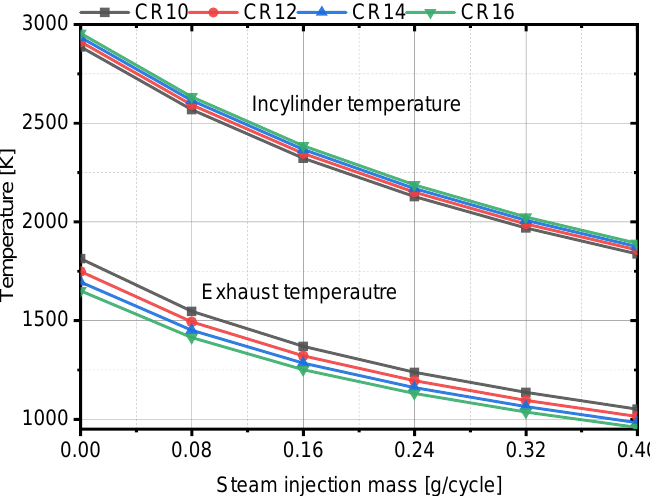
Figure 8. Relationships between in-cylinder/exhaust temperatures and steam injection mass at different compression ratios (T steam = 450 K; P steam = 20 MPa; P intake = 0.1 MPa).